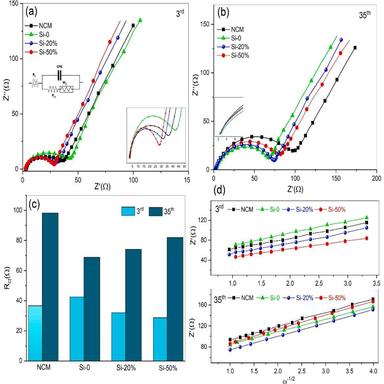
Nyquist curves of all samples, (a) 3rd cycle, (b) 35th cycle, (c) Rct of all samples after 3rd and 35th cycle, and (d) relationships between ω− 1/2 and Z′.